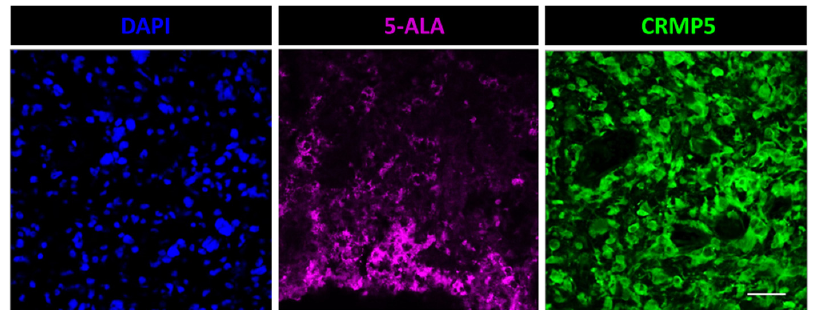
Figure 3. Fluorescence microscopy for 5-ALA and immunofluorescence with anti-CRMP5 of adjacent sections in a case of GBM (Case #12 on Table 1). About 60% of the CRMP5 expressing tumor cells (green) do fluorescence after 5-ALA (purple). Scale bar, 40 µ m. Objective lens, Olympus UPlanSAPO 40 × /0.95 Oil.